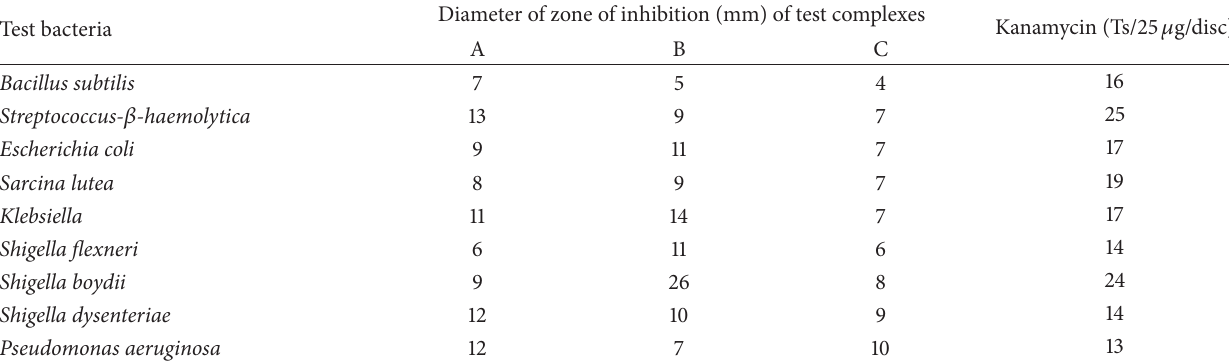
Table 15: Result of antibacterial activity of test